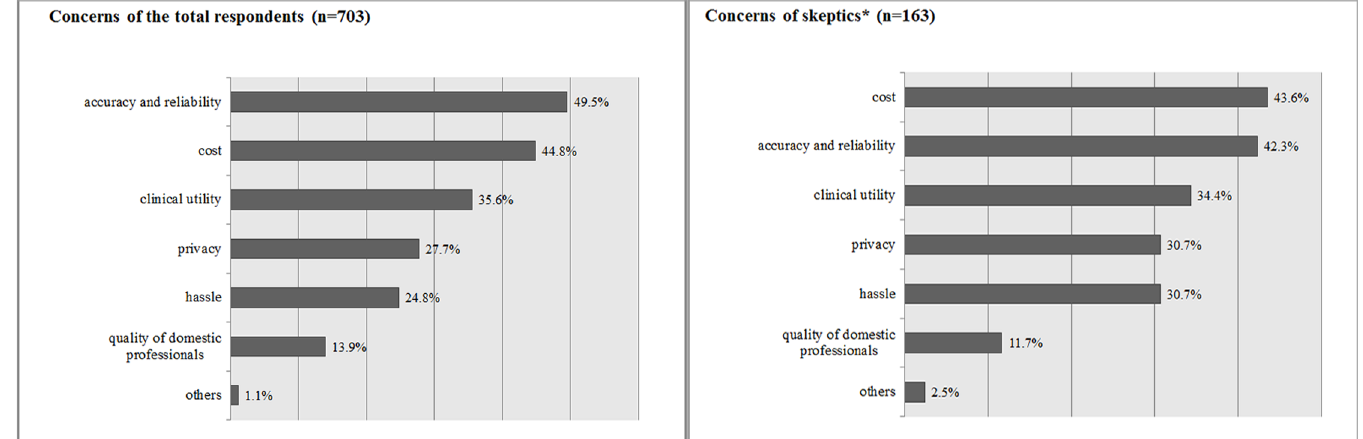
Fig 1. Concerns about clinical application of pharmacogenomic testing. Respondents were asked to select their two biggest concerns from a list. (cid:3) Skeptics include those who were neutral, disagreed, or strongly disagreed with the idea of incorporating the integrated pharmacogenomics test into the National Health Insurance health examination.